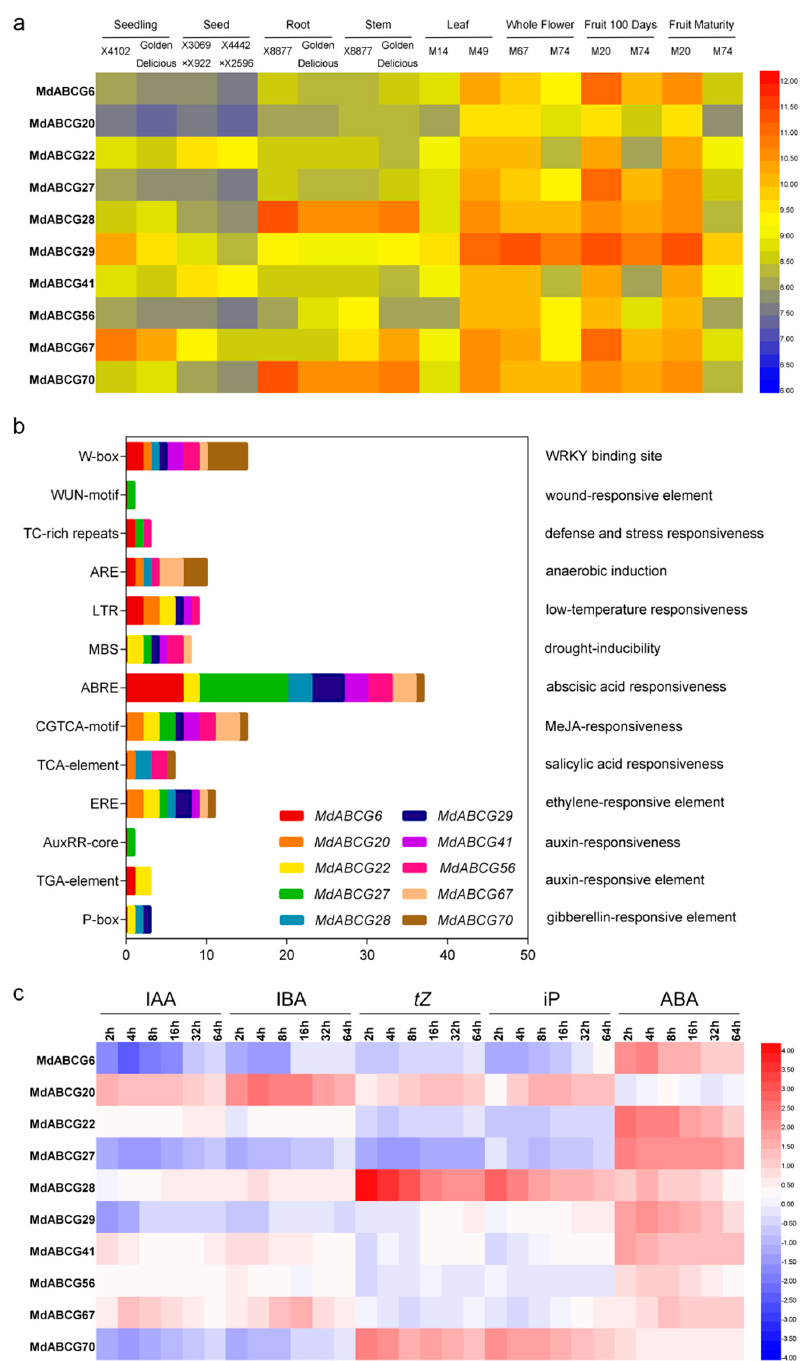
Figure 3. Expression profiles of 10 potential phytohormone transporters in MdABCG subfamily genes. ( a ) Tissue expression profiles obtained from ArrayExpress data displaying diverse expression levels of 10 potential phytohormone transporters in MdABCG subfamily genes in di ff erent tissues. Relative transcript levels based on ArrayExpress data are presented as heat maps from blue to red, reflecting relative signal values. ( b ) Cis-elements analysis. These cis-elements responded to environmental stress and phytohormone signal in the sense strands of 10 MdABCG subfamily gene promoters. The x -axis indicates the number of each cis-element. ( c ) Inducible expression profiles of 10 MdABCG subfamily genes under indole-3-acetic acid (IAA) (1 mM), indole-3-butyric acid (IBA) (1 mM), trans -zeatin ( t Z) (1 mM), N 6 -( ∆ 2 -isopentenyl) adenine (iP) (1 mM), or abscisic acid (ABA) (1 mM) in apple callus. The color scale represents the log2 transformed gene relative expression compared with